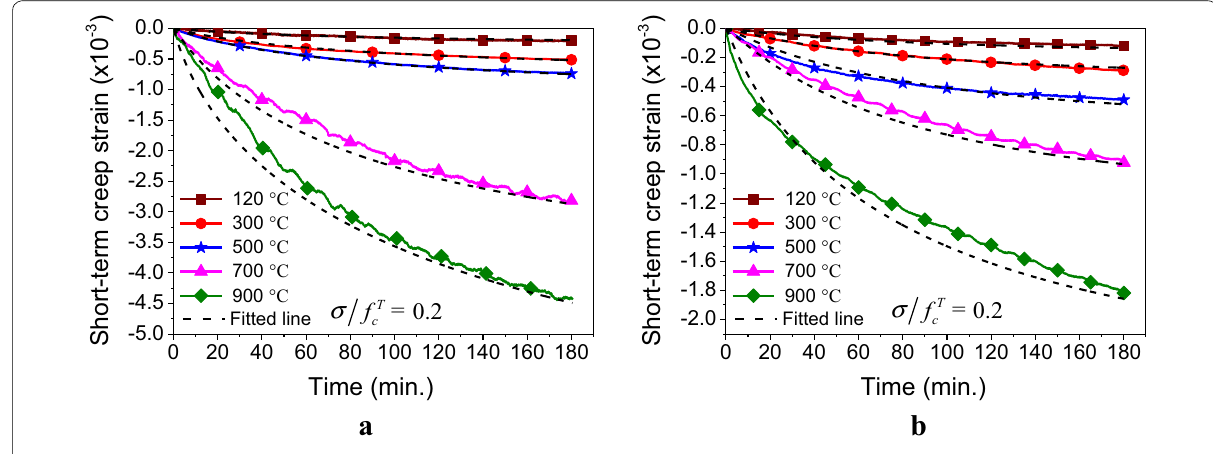
Fig. 6 STC at 20% stress level of a HRPC and b PRPC specimens.